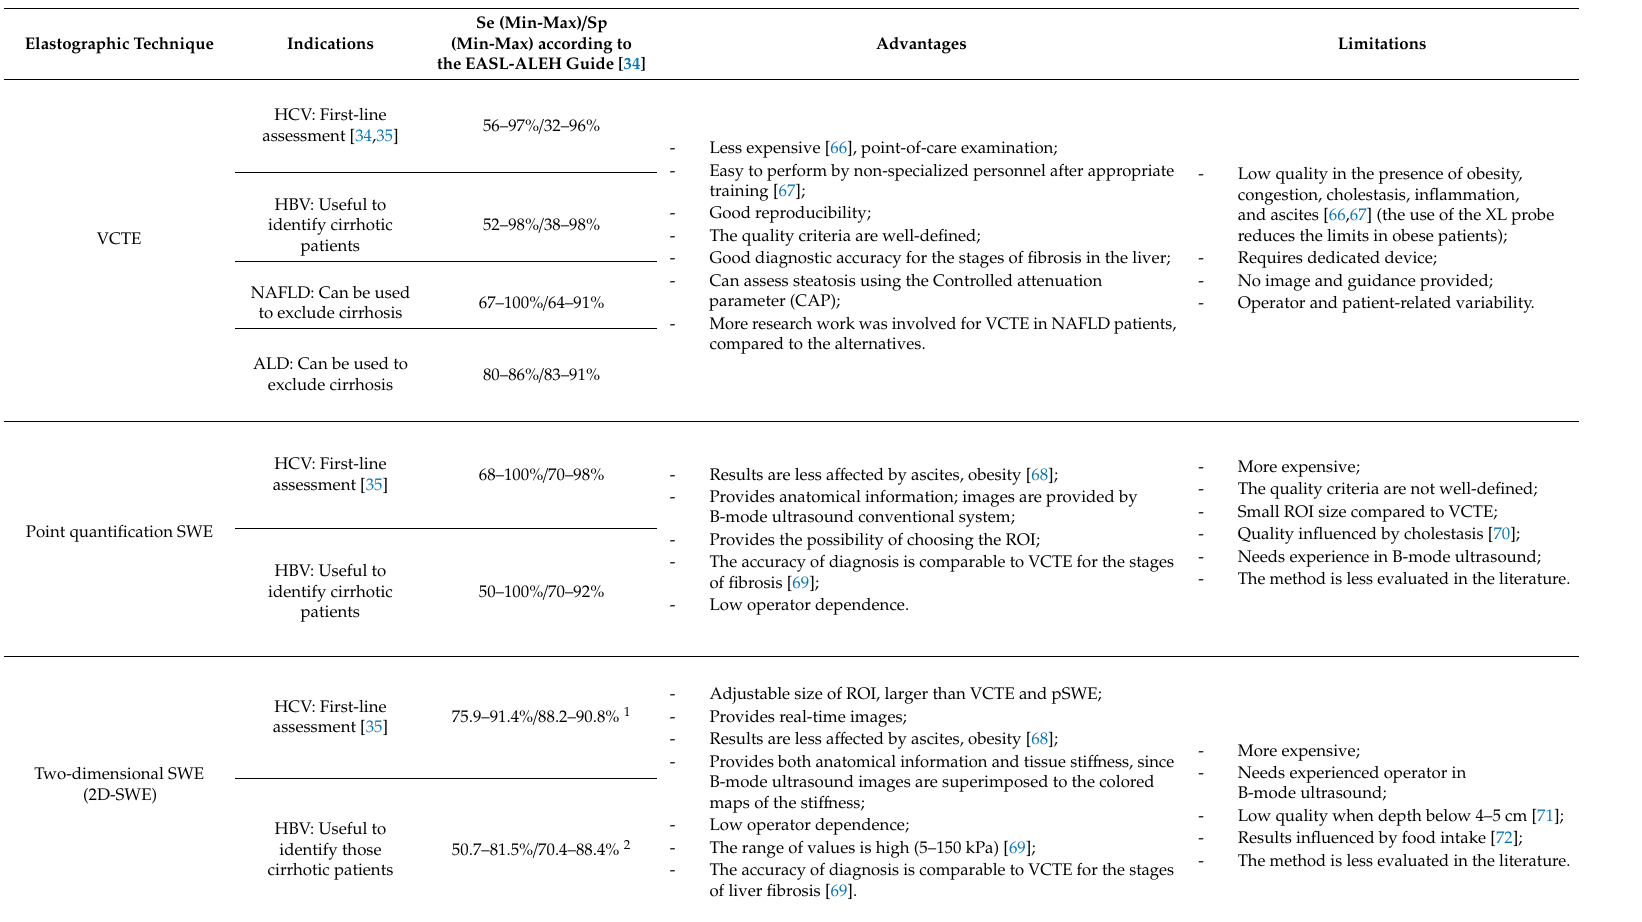
Table 1. Summary of advantages and limitations of each quantitative ultrasonic elastography technology. The current clinical indications and the corresponding sensitivity and specificity are described as well, with the mention that studies are underway for several other liver pathologies, including